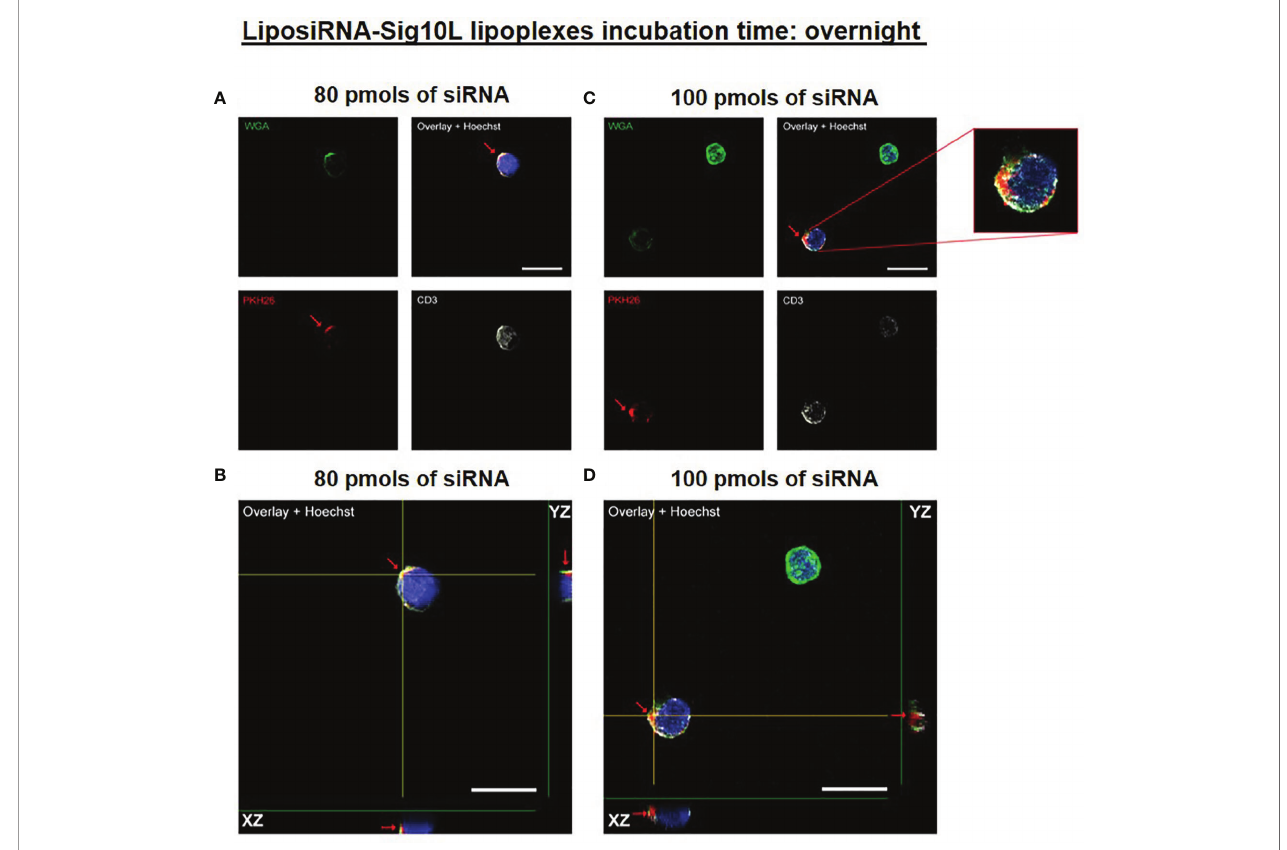
FIGURE 2 | PKH26-labeled LiposiRNA-Sig10L internalization in HD PBMC after O/N of incubation. Confocal microscopy images show the internalization of LiposiRNA-Sig10L particles (PKH26 positive dots, arrows) in CD3 + (white) cells among HD PBMC after O/N treatment with lipoplexes at 80 (A) and 100 (C) pmols of siRNA. Confocal Z reconstructions show the internalization of PKH26-labeled LiposiRNA-Sig10L particles in CD3 + lymphocytes (arrows) upon treatment with different doses of lipoplexes 80 (B) and 100 (D) pmols of siRNA. Cell membrane and nuclei are stained with WGA (green) and Hoechst dye (blue) respectively. Bar: 10 m